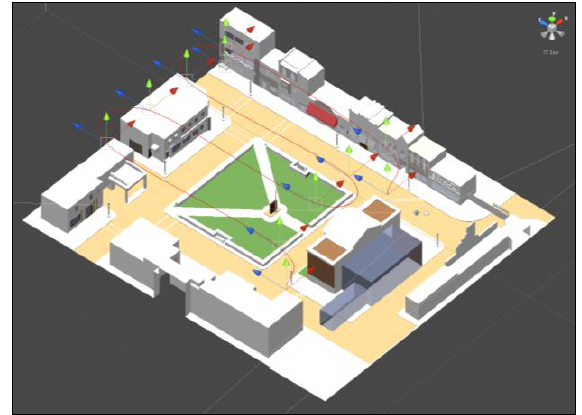
Figure 3: a simulated flight plan for 3D building modelling